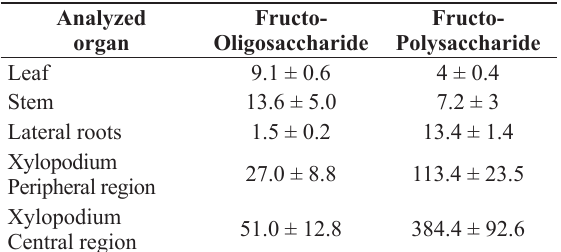
Distribution of total fructose (mg g −1 DM) in different vegetative aerial and underground organs of Dimerostemma vestitum . Values are means ± sd ( n =